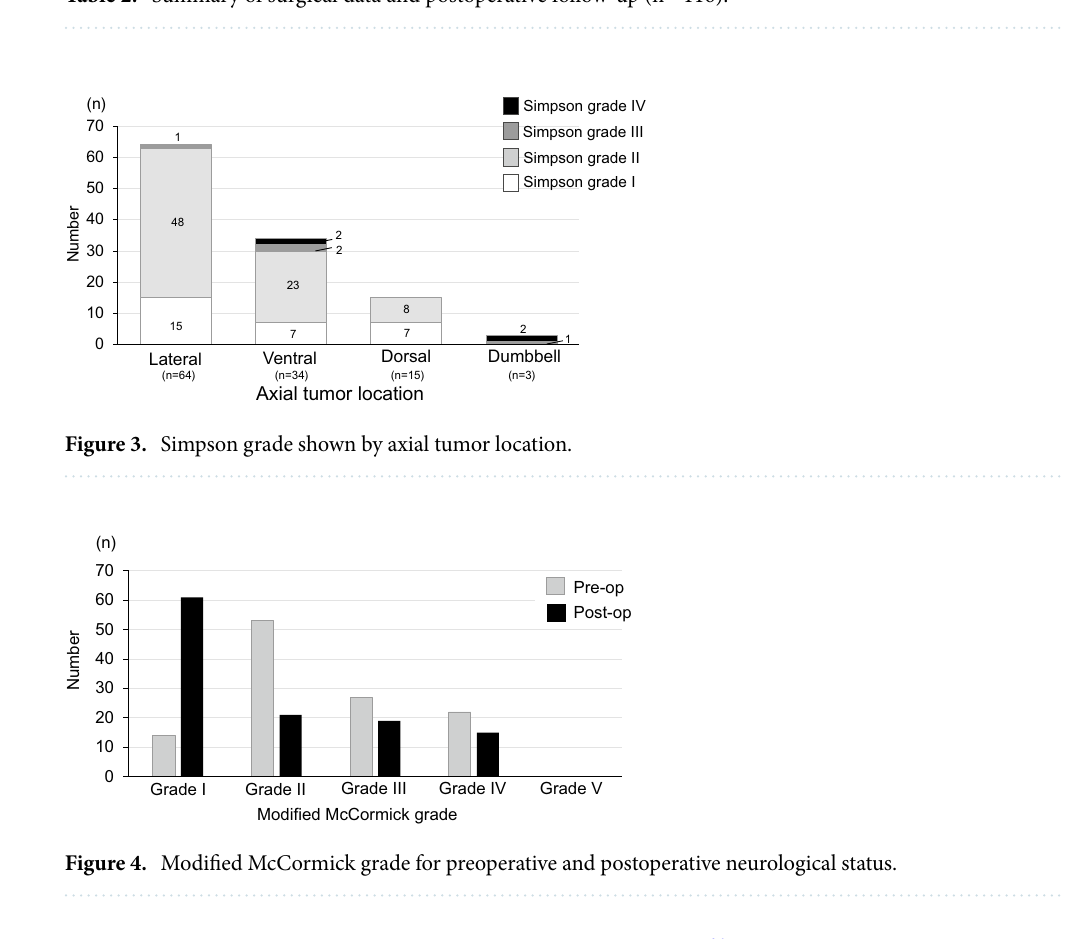
Table 2. Summary of surgical data and postoperative follow-up (n = 116).